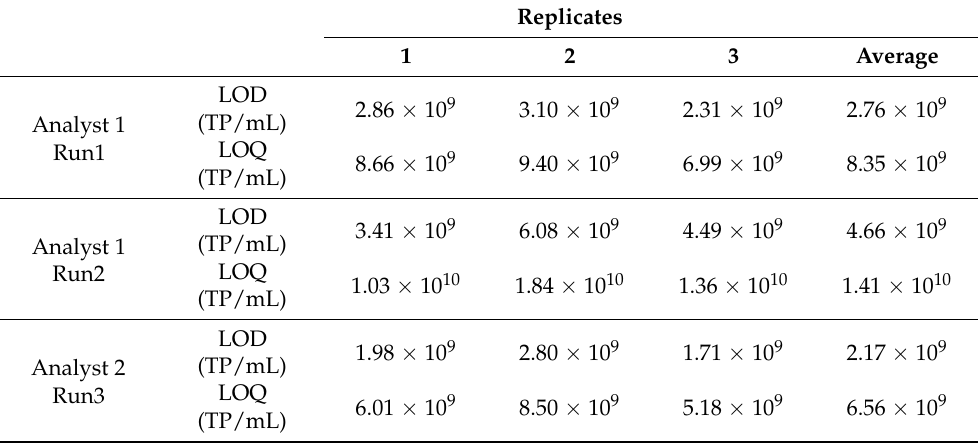
Figure A3. Representative chromatogram of LV purification using anion exchange chromatography (AEX) with step elution. (A) Washing step. (B) Low Ionic Strength Step Elution. (C) High Ionic Strength Step Elution. Table A2. CE-SDS LIF method qualification for quantification of AAV using a Reference standard AAV2 sample; LODs and LOQs and their average estimation are shown. LODs and LOQs were calculated based on signal to noise ratio methodology for each experiment.